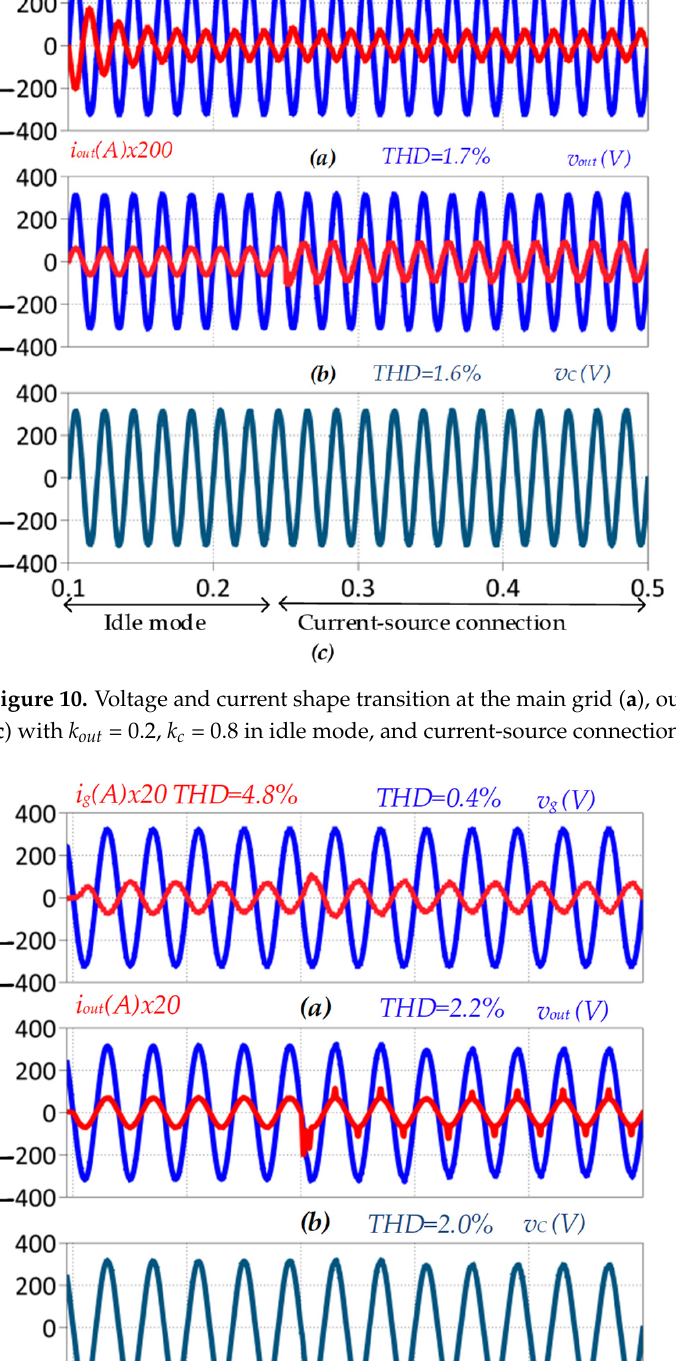
Table 2. Comparison of THD results of the ER parameters for different scenarios.